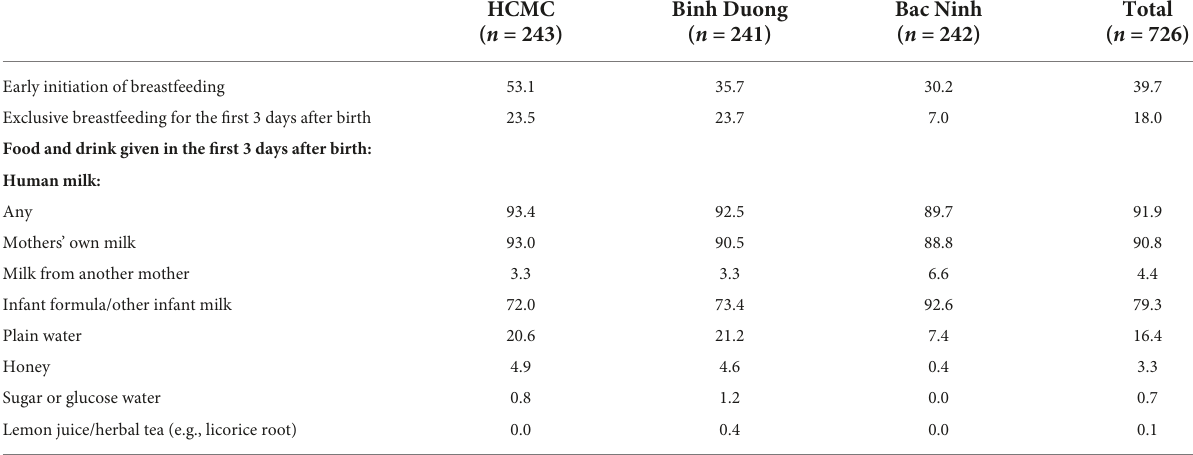
TABLE 2 Feeding practices in the first 3 days after birth reported by mothers of infants 0–11 months, three provinces, Vietnam, 2020 1